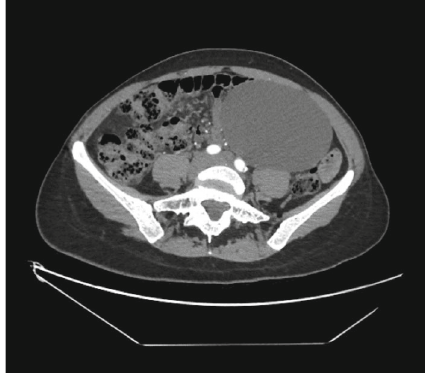
Figure 2: CT scan with a cystic derivative in the left lower abdominal quadrant.